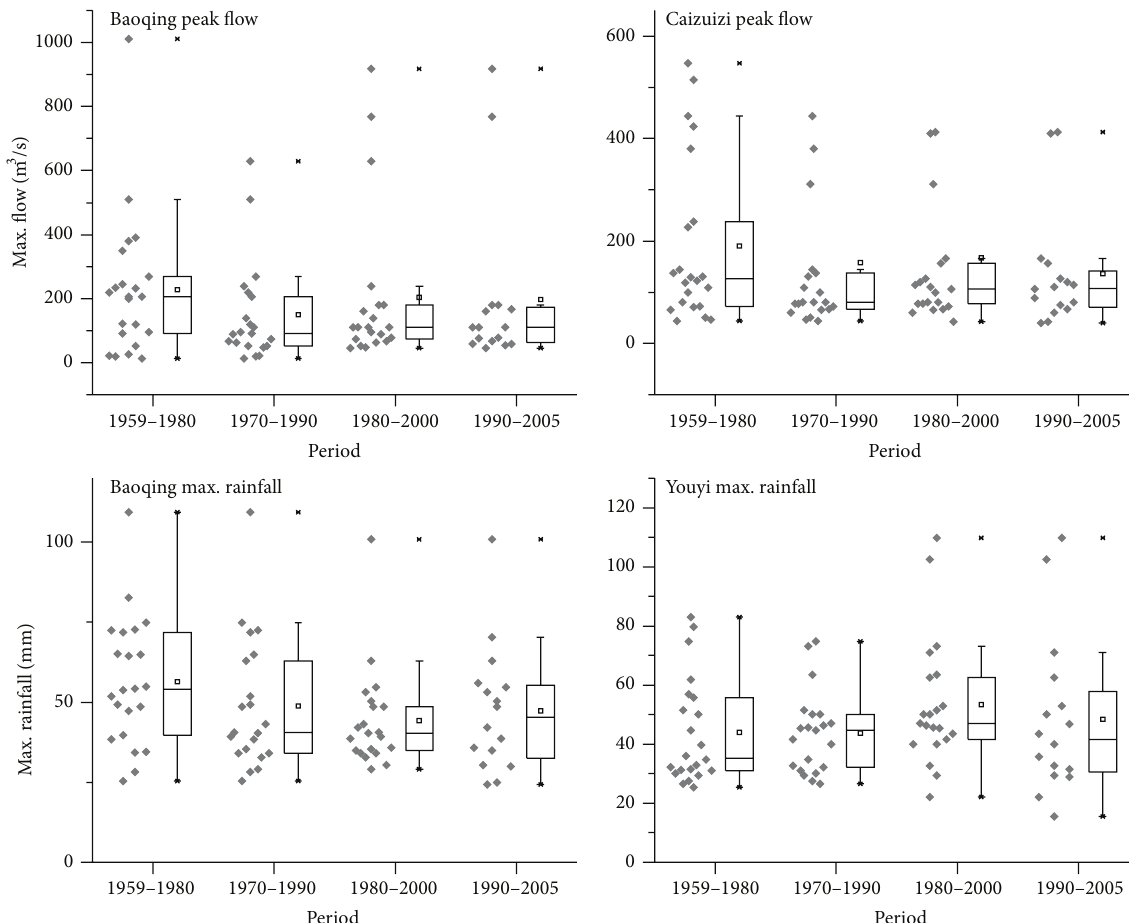
Figure 4: Peak flow and maximum rainfall magnitude across four time periods. Boxplots represent data from different periods; the horizontal line in each boxplot is the median, while the square box holds the